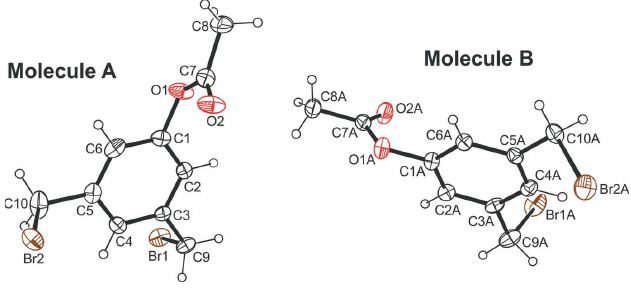
Figure 2 Perspective view of the molecular structure of 2 . Anisotropic displace- ment ellipsoids are drawn at the 50% probability level.